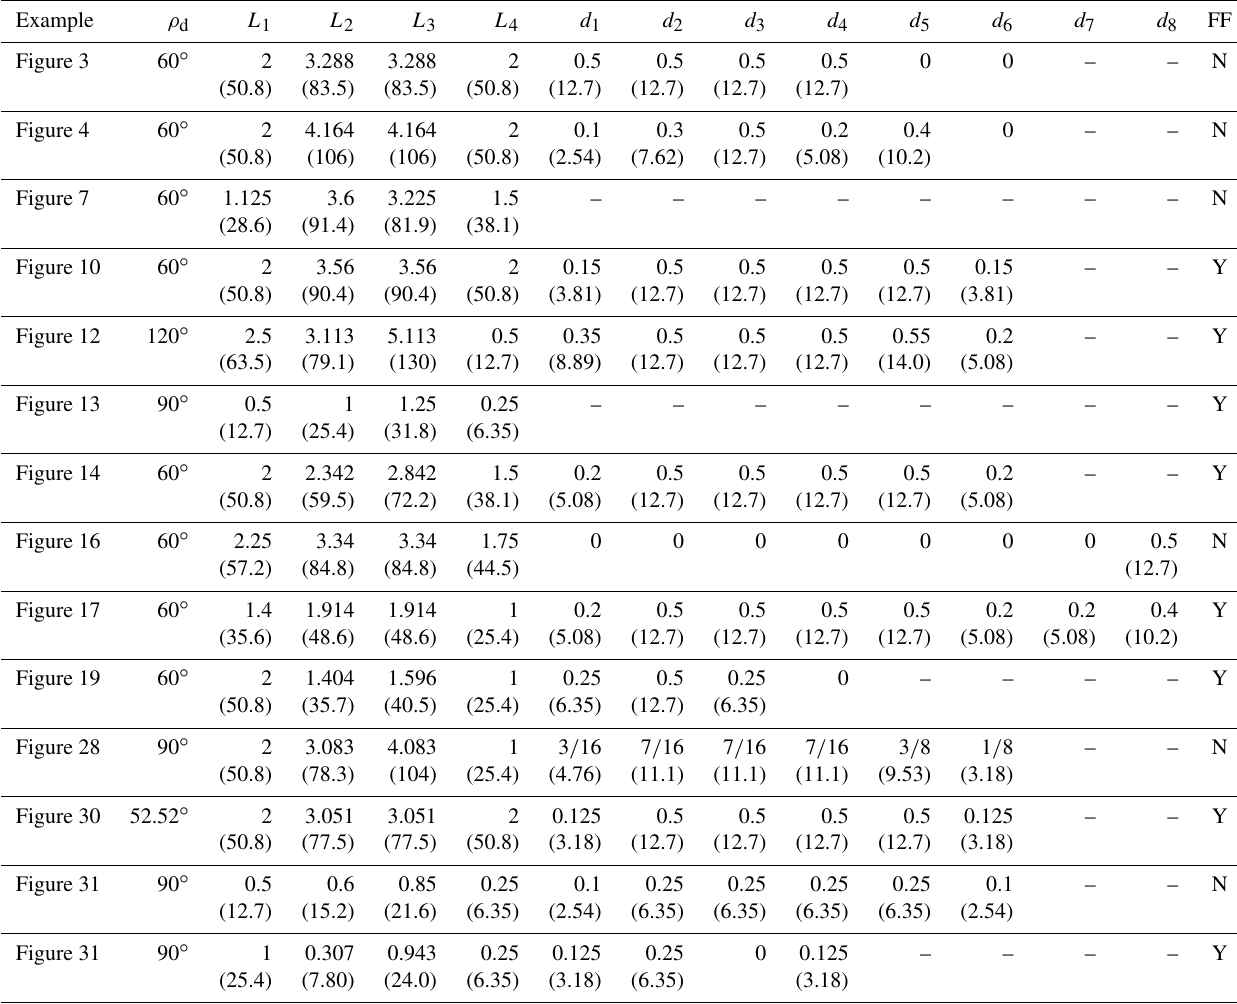
Table A1. Parameter values for planar deploying strut ThUDS examples. Lengths are in inches (millimeters). Parameters marked “–” are not part of the technique used to create that prototype. Whether flat foldability (FF) is possible is denoted in the last column.